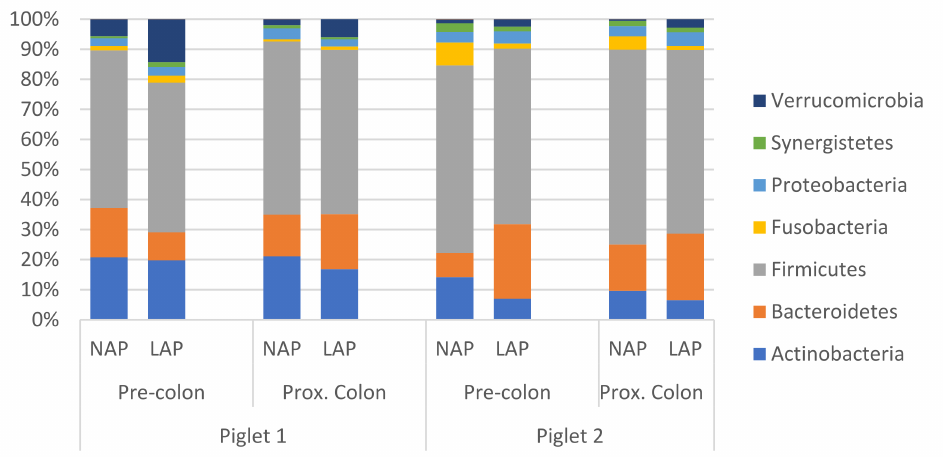
Figure 3. Relative abundances of the phyla observed in the pre-colon and proximal colon bioreactors of baby-SPIME when using AP (LAP) or not (NAP) for two donor